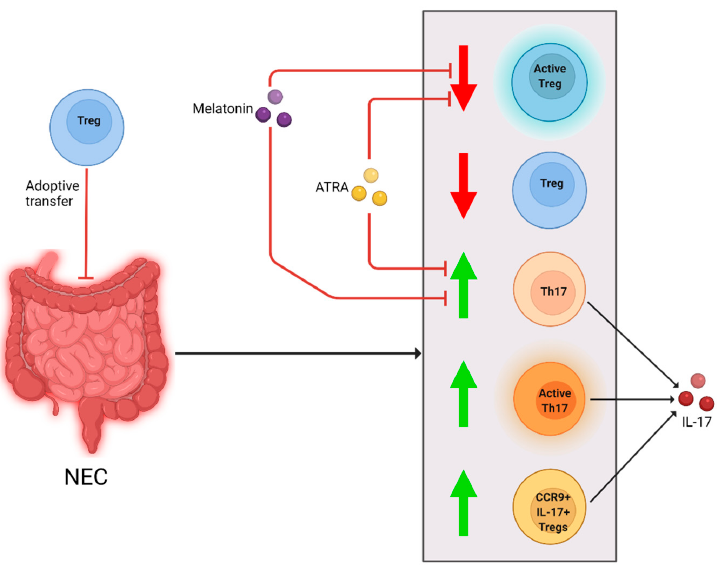
Figure 2. Cellular changes observed in NEC patients and animal models and different interventions. After NEC diagnosis or induction, Treg levels and activity were reduced (downward arrow). Th17 and CCR9 + IL-17+ Treg levels, and Th17 cell activity were increased (upward arrow). Melanin and ATRA negated the decrease in Tregs and increase in Th17 cells and IL-17. Adoptive Treg-transfer reduced NEC development in a mouse